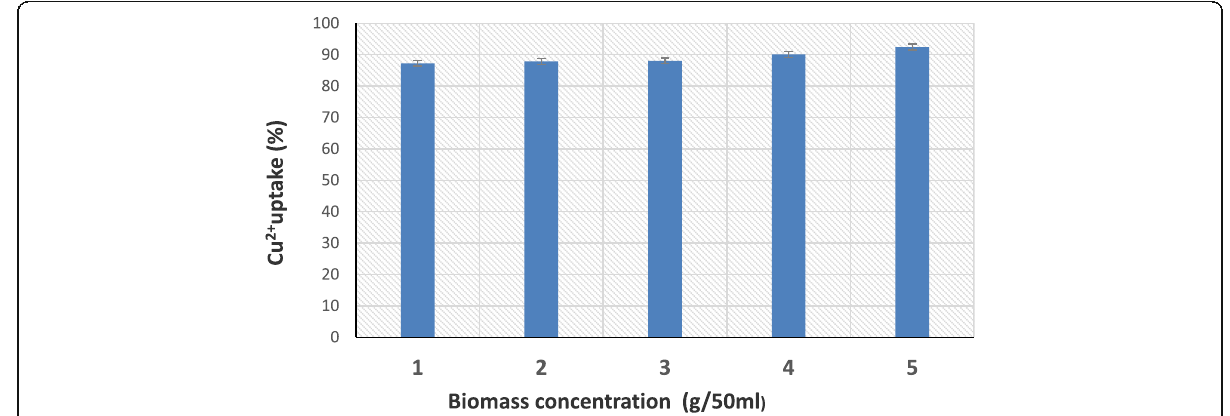
Fig. 2 Effect of biomass concentration on Cu 2+ uptake by Aspergillus tamarii NRC 3 biomass (Cu 2+ conc., 80